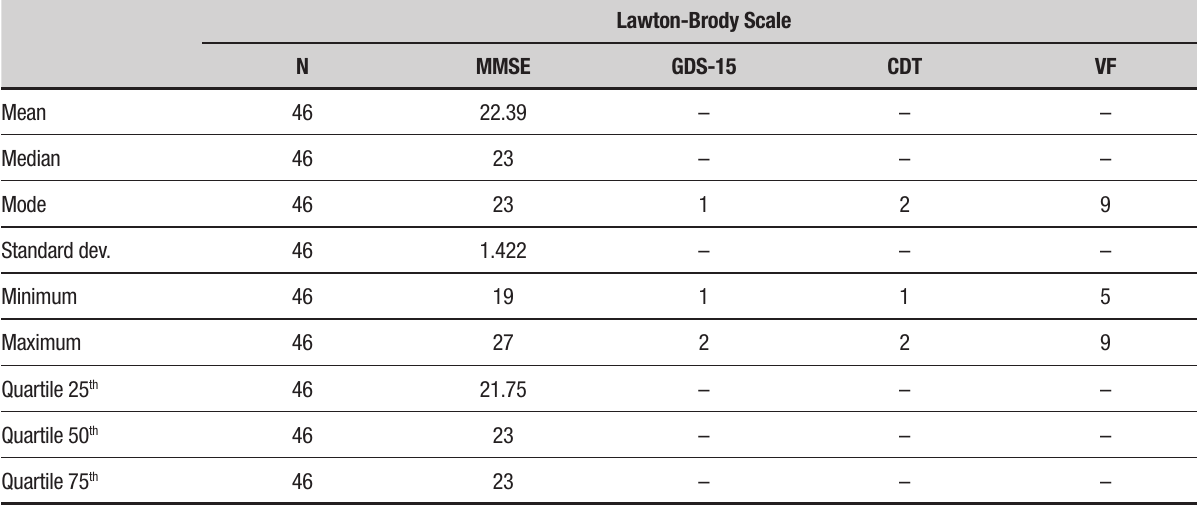
Table 1. Characteristics of screening test